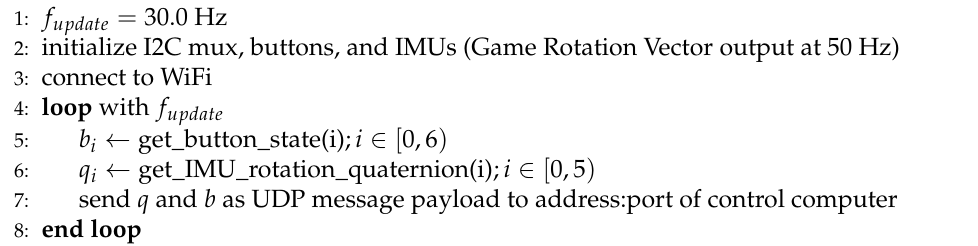
Figure 3. Connections and protocols. Algorithm 1 Wearable IMU system: Rotation and button state